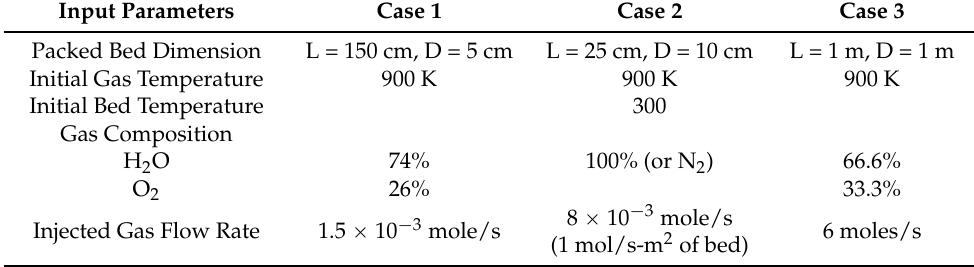
Table 10. Input parameters for the three situations considered by Thorsness and Kang [51].